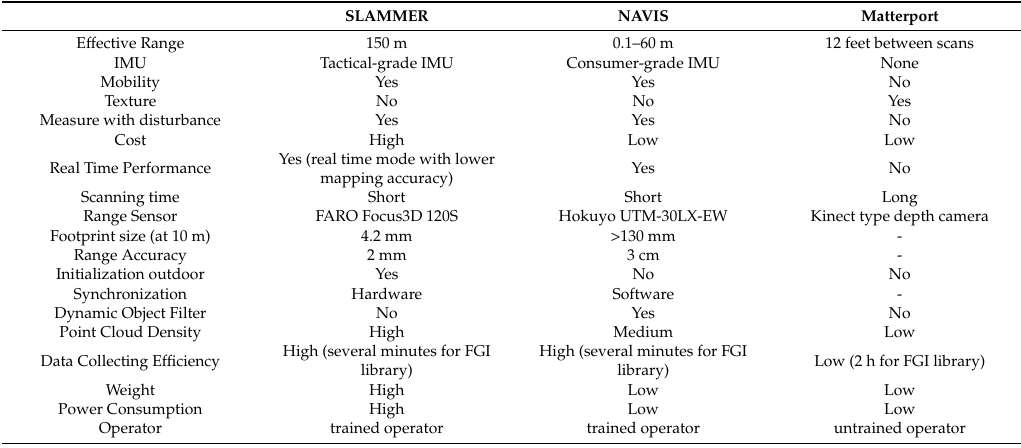
Figure 13. ( A ) Glass book cabinet misdetected by the Matterport sensor, ( B ) a bookshelf behind chairs; ( C ) a wardrobe behind stairs. Table 9. Comparison of SLAMMER, NAVIS and